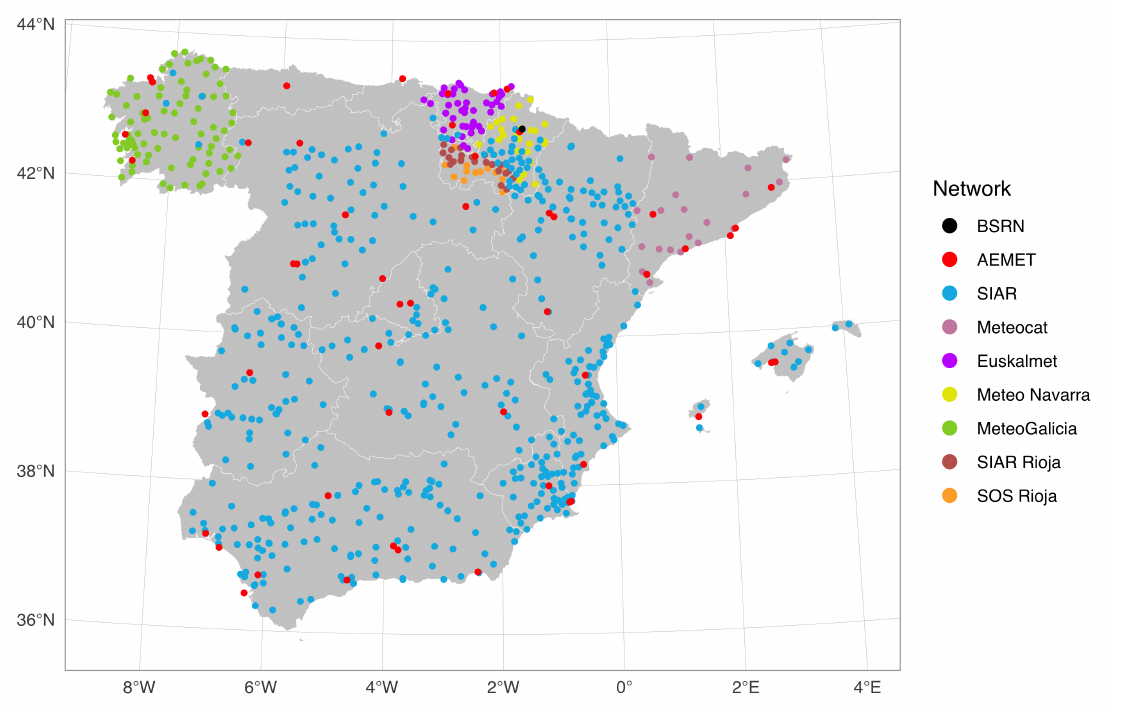
Figure 1. Locations of the weather stations used in the study. Table 1. Description of the monitoring networks used in the study. The values in brackets in the temporal resolution column are the interval midpoints. Types of pyranometers: secondary